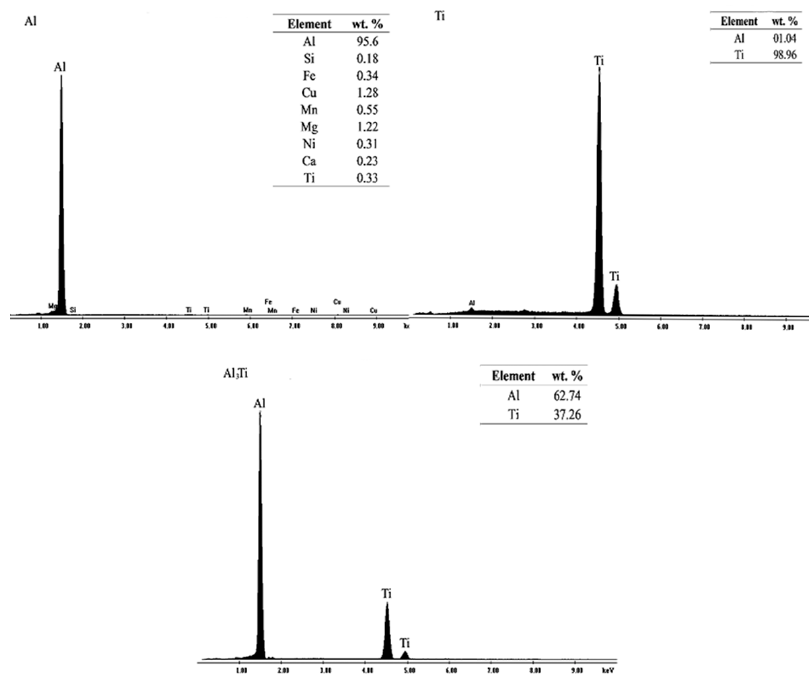
Figure 10. Energy dispersion spectroscopy (EDS) patterns for the Ti-rich particle.